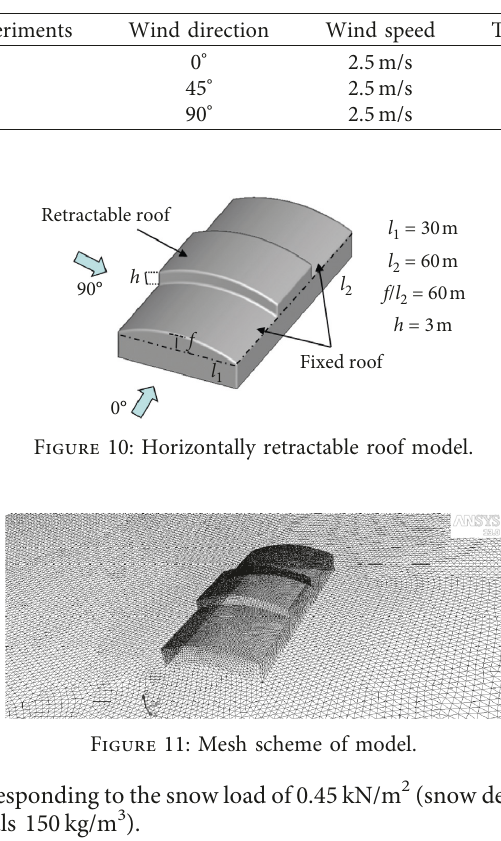
Table 5: Details of experimental conditions.